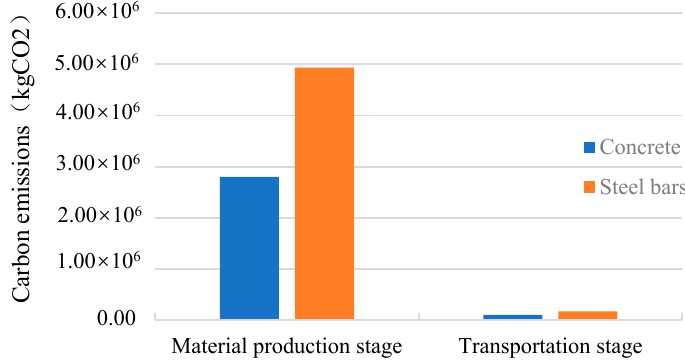
Figure 5. Carbon emissions of different materials at different stages.